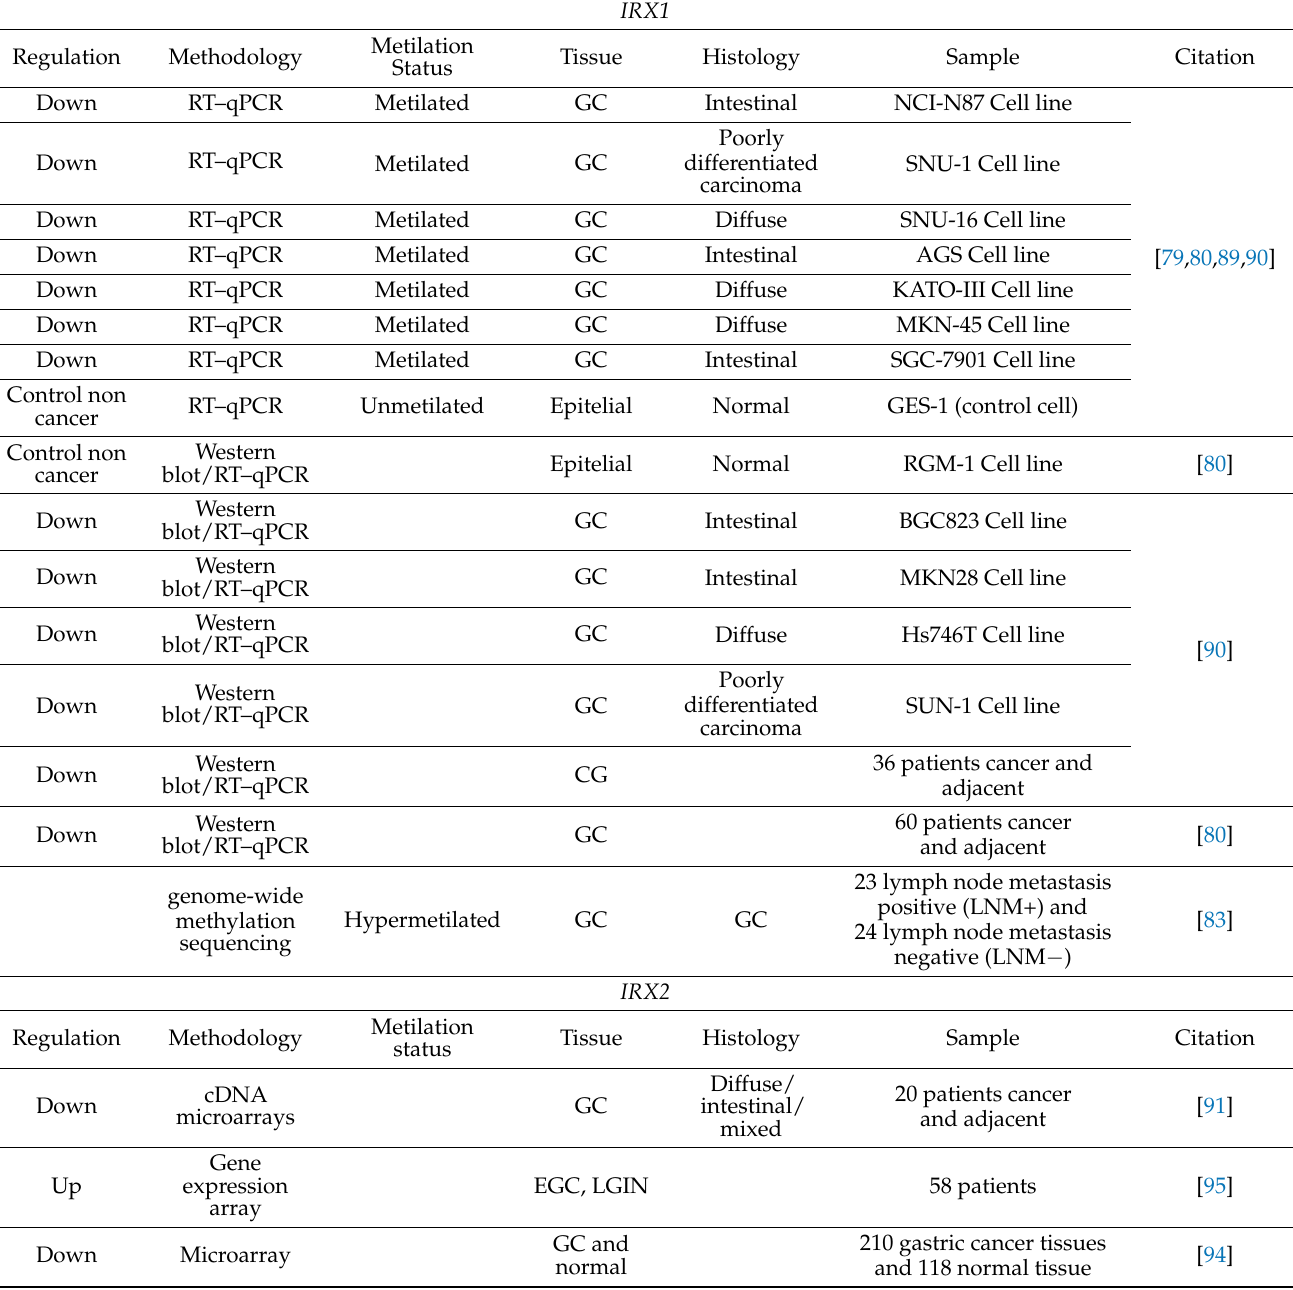
Table 1. Iroquois family genes in gastric cancer